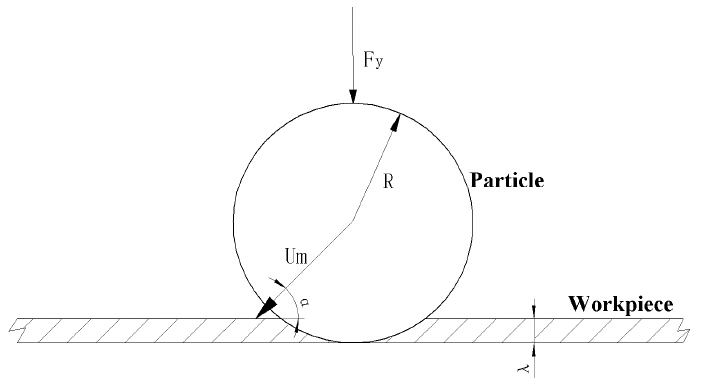
Figure 1. A schematic diagram of the erosion from a single abrasive particle.